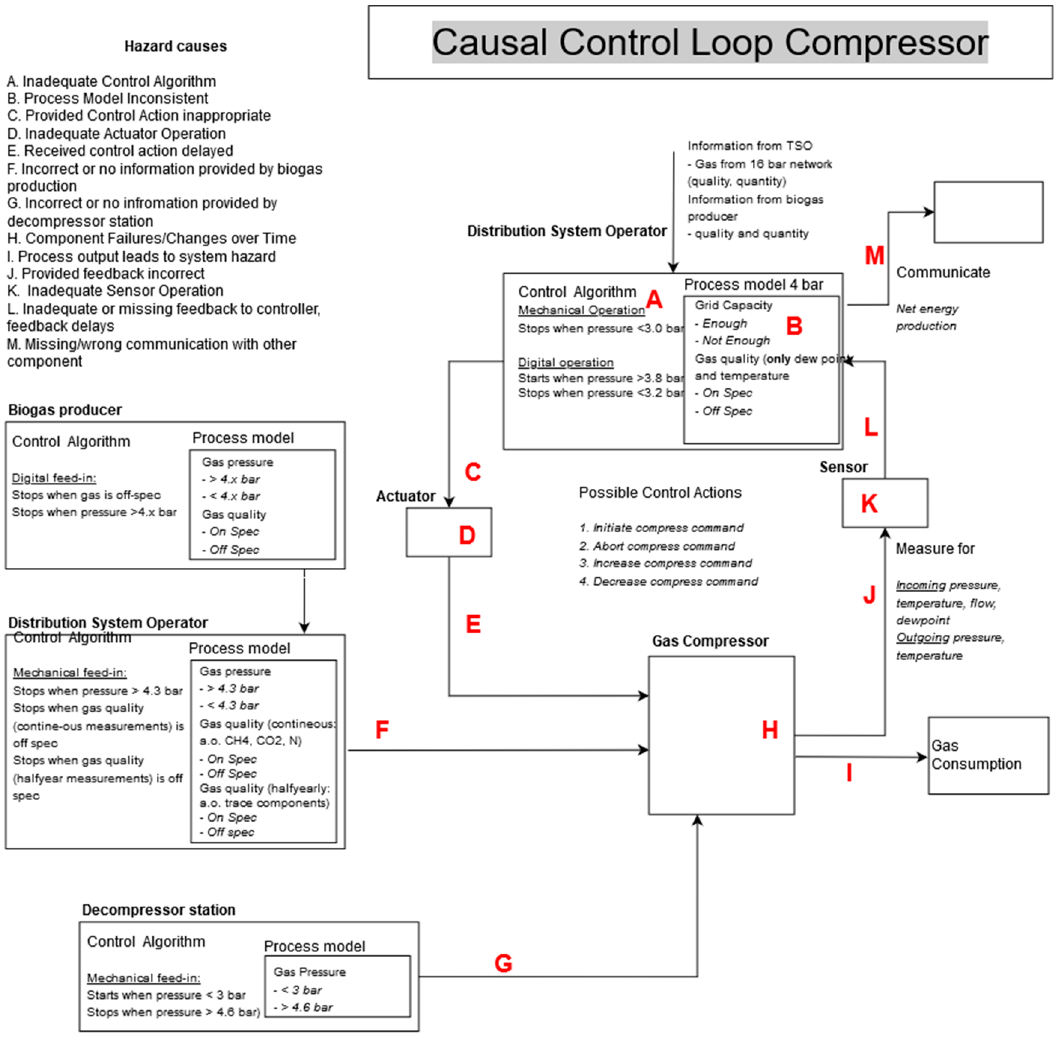
Figure A2. Causal loop compressor.